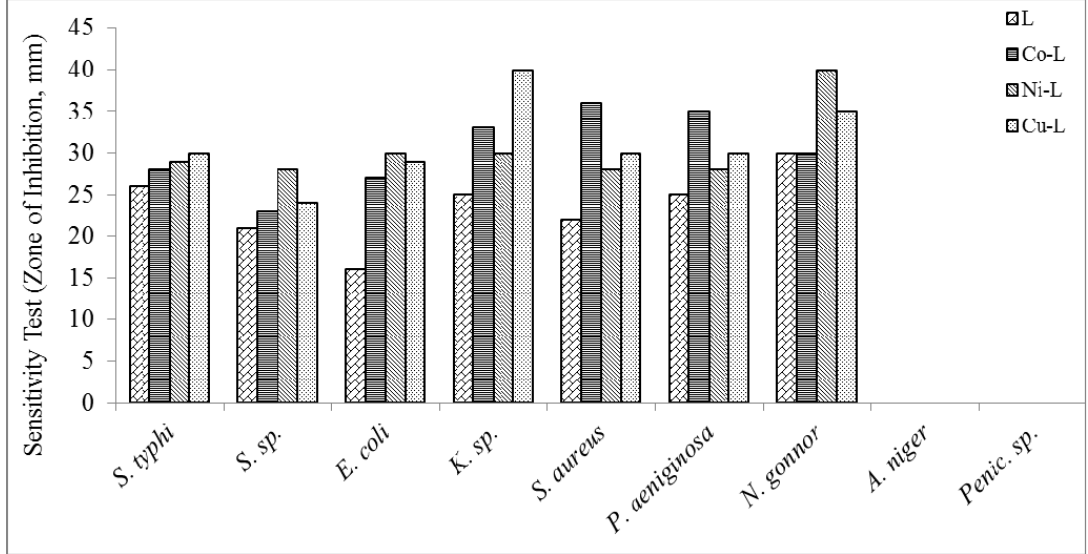
Figure 1. Sensitivity test of the ligand and metal complexes against some micro-organisms.